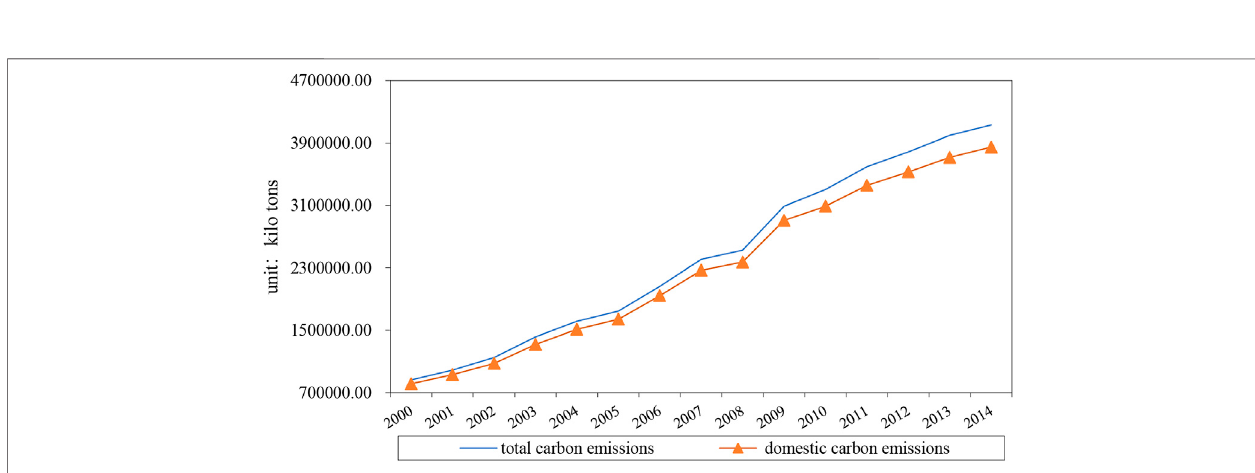
FIGURE 2 | The total carbon emissions and the domestic carbon emissions of China ’ s construction industry during 2000 – 2014.